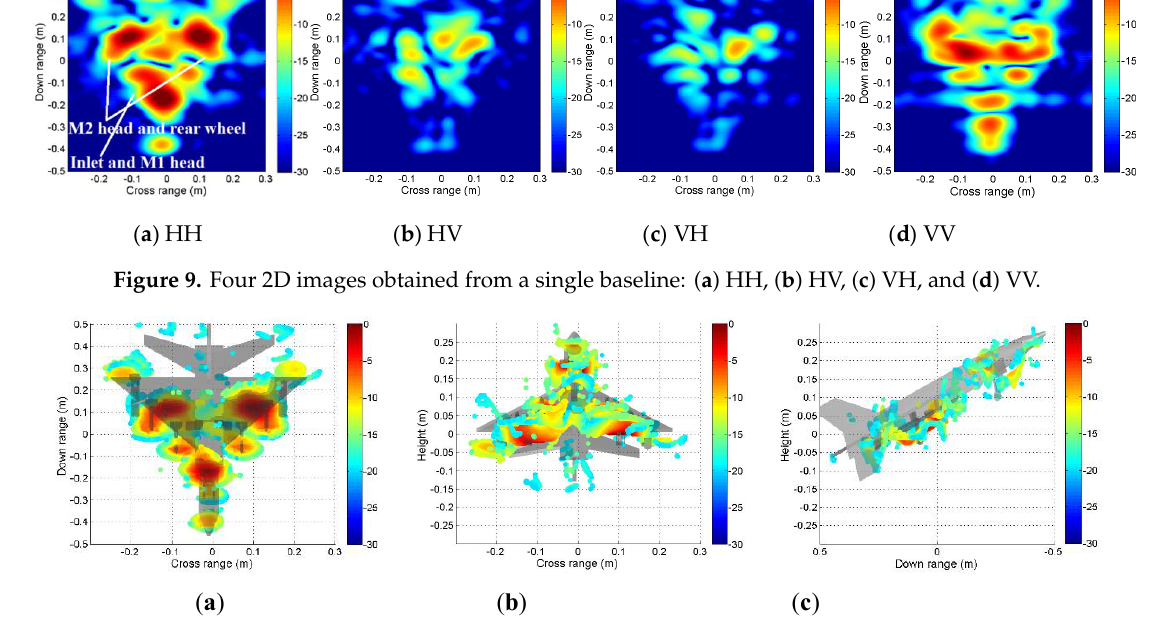
Figure 10. Tomography results in HH polarization. Three views of the airplane model are shown: ( a ) top view; ( b ) bottom view; ( c ) side view. ( a ) top view; ( b ) bottom view; ( c ) side